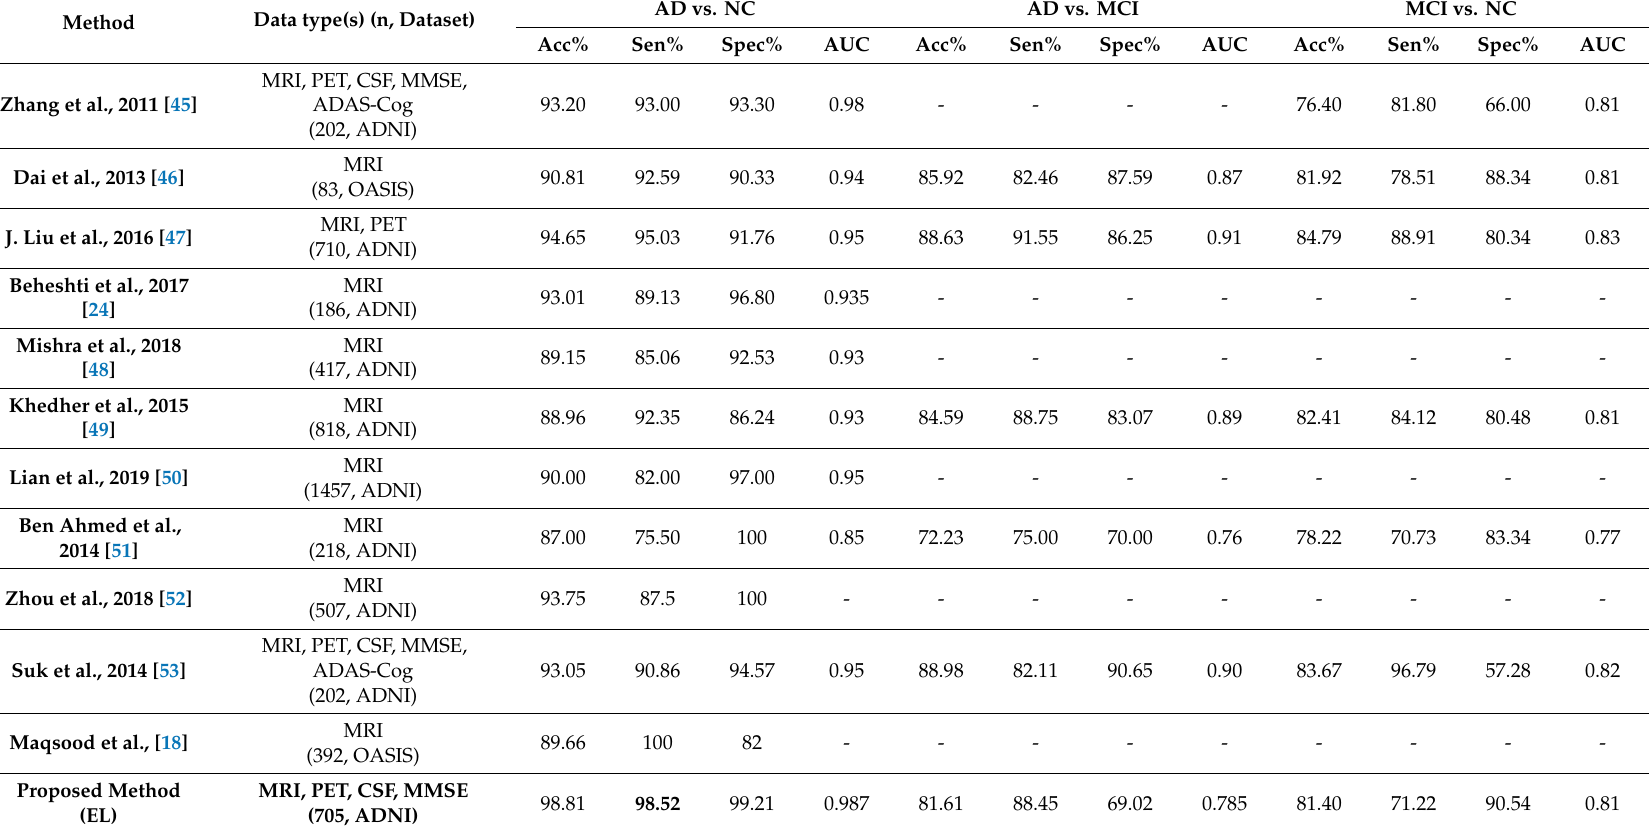
Table 3. Comparison of the proposed method with other methods; including dataset and indicators. EL: Emphasis Learning. ADNI: Alzheimer’s Diseases Neuroimaging